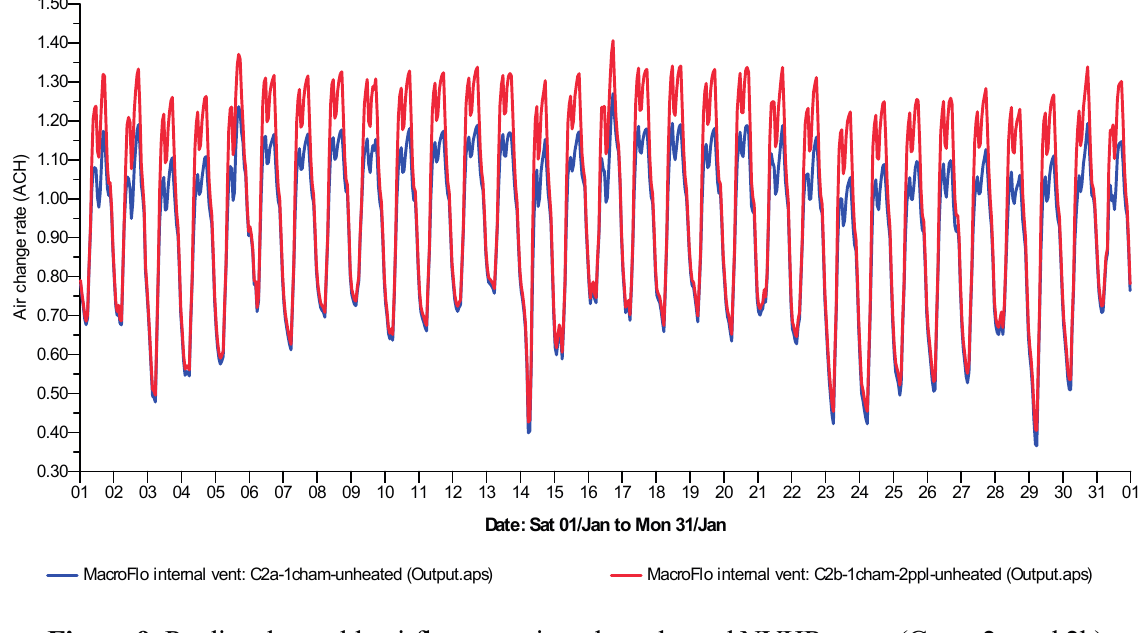
Figure 9. Predicted monthly airflow rates into the unheated NVHR cases (Cases 2a and 2b). Table 3. Summary of predicted values for DRT and Airflow rates in NVHR